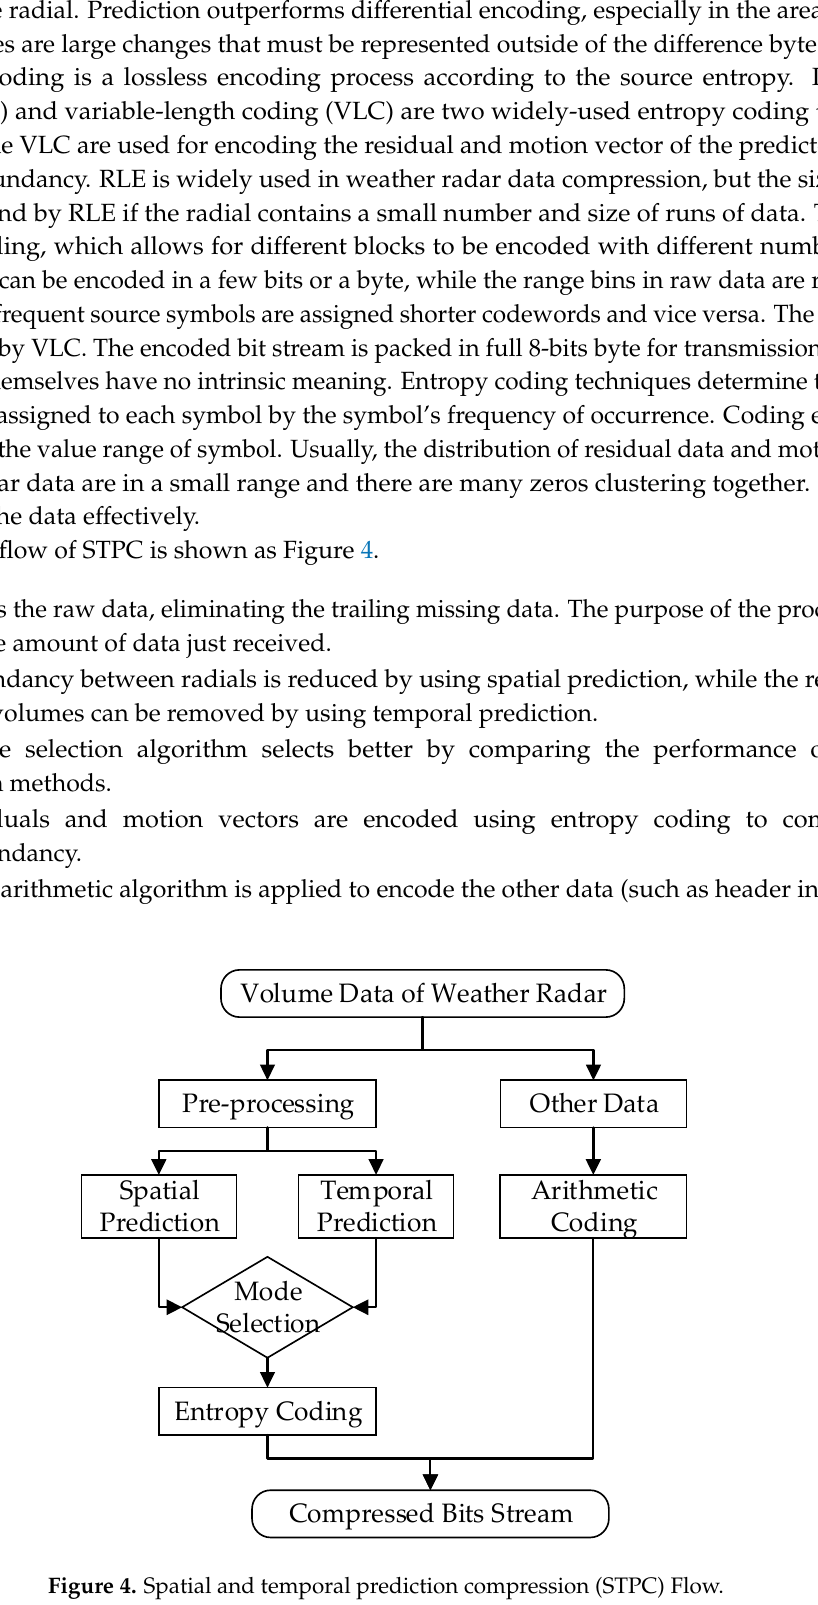
Figure 4. Spatial and temporal prediction compression (STPC) Flow.